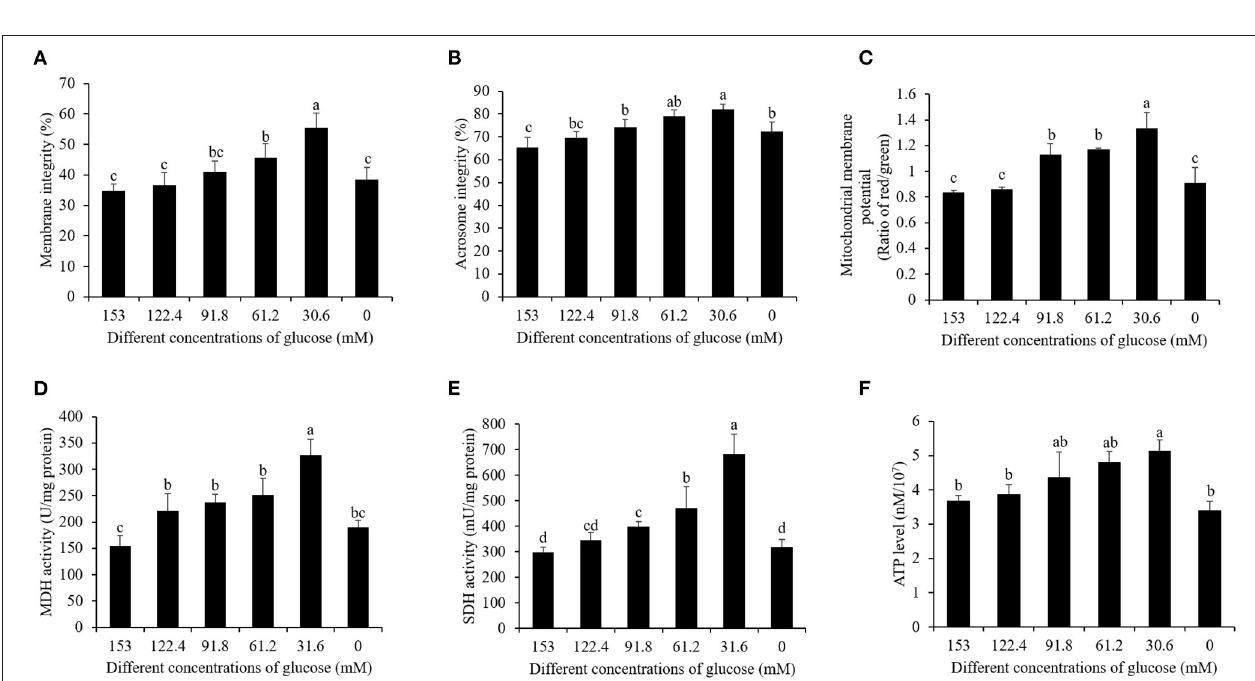
FIGURE 4 | Effects of different glucose levels in the pretreatment solution on boar post-thaw sperm membrane integrity (A) , acrosome integrity (B) , mitochondrial membrane potential (C) , MDH level (D) , SDH level (E) , and ATP level (F) after thawing. Values are specified as mean ± standard deviation. Columns with different lowercase letters differ significantly ( p < 0.05). MDH, malate dehydrogenase; SDH, succinate dehydrogenase.